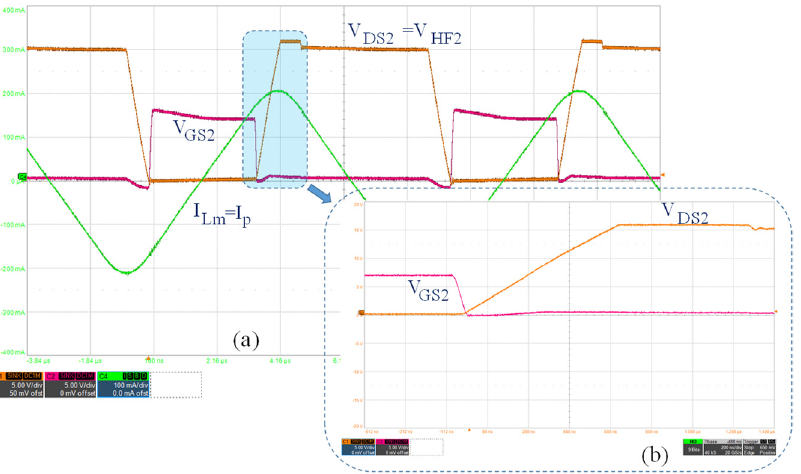
Figure 19. ( a ) Switching waveforms of gate-source voltage and drain-source of low-side MOSFET with the magnetizing current of the main HF transformer. ( b ) Focus on zero-voltage switching waveforms operation. V DS2 = V GS2 = 5 V/div, I Lm = 100 mA/div, ( a ) t = 2 μ s/div, ( b ) t = 200 ns/div.